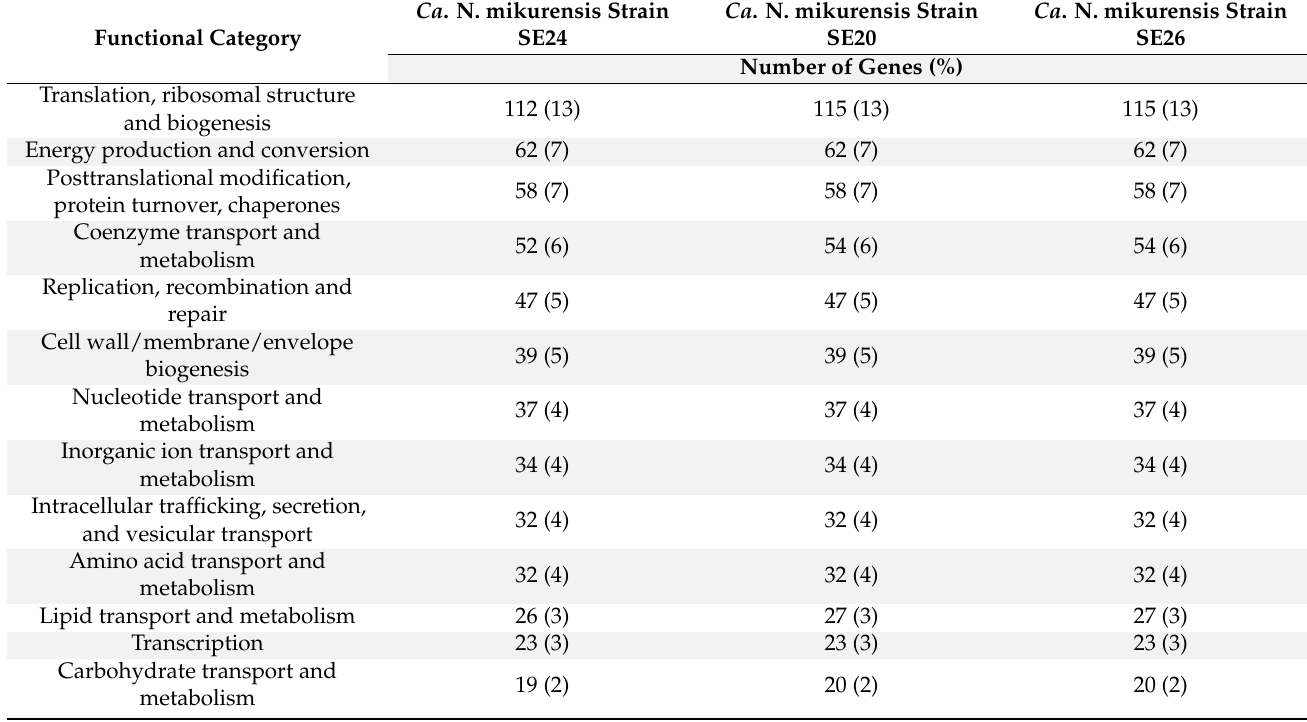
Table 3. Functional Clusters of Orthologous Groups of protein-coding genes from the three sequenced Ca . N. mikurensis